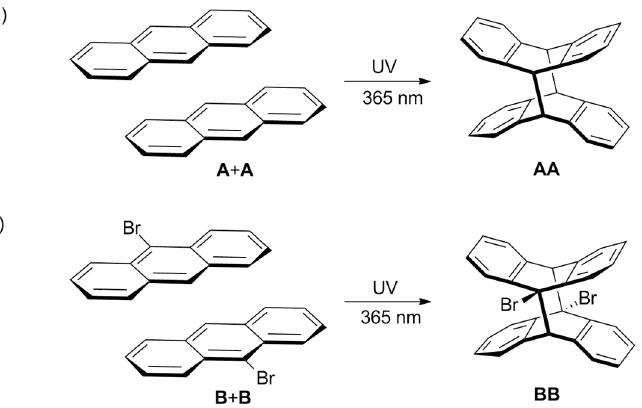
Figure 1. Photodimerization of ( a ) anthracene ( A ) and of ( b ) 9-bromoanthracene ( B ). For B only trans isomer is presented as we suppose that this isomer was obtained in the case of our research.